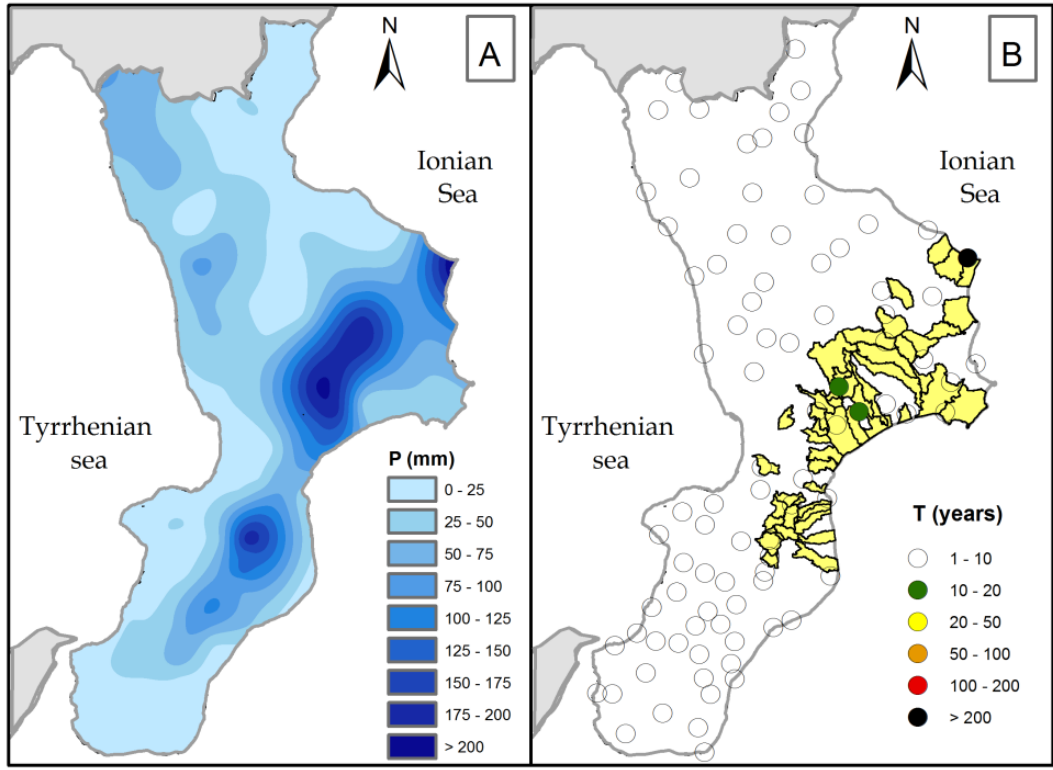
Figure 2. 19 November 2013: ( A ) daily rainfall map; ( B ) return period of daily rainfall ( T ) at the gauges (circles with different colors according to the legend), and damaged municipalities (yellow